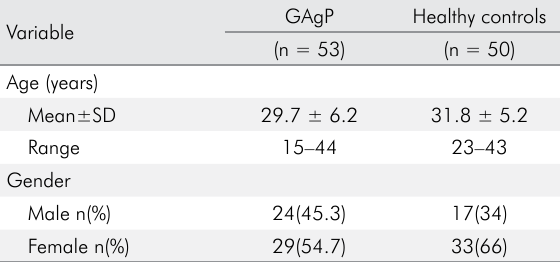
Table 2. Demographic characteristic of study groups.